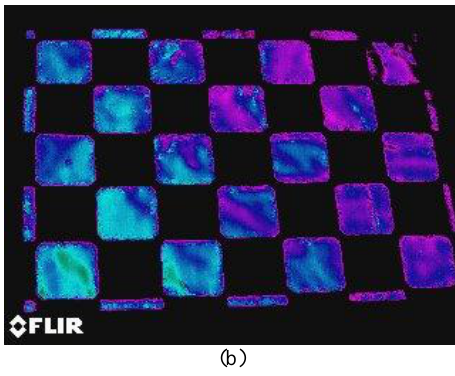
Figure 3. Checkerboard used for the geometric calibration of the IR camera: (a) photograph; (b) infrared image